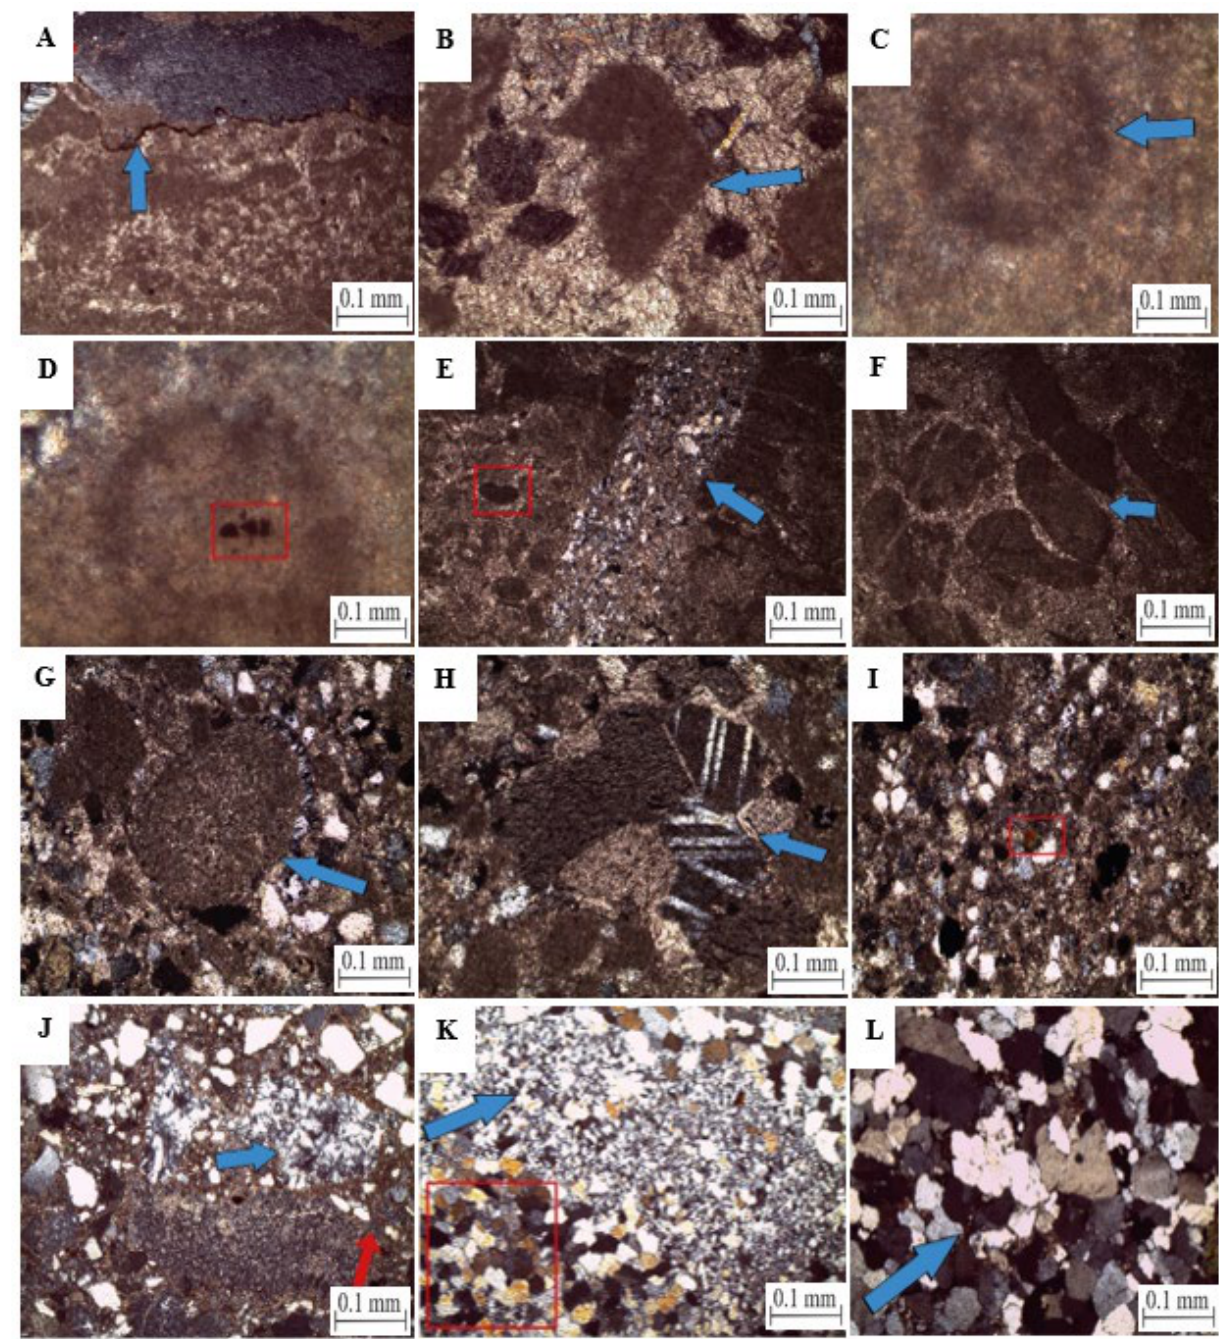
Figure 9. Photomicrographs of the Dol. III, IV and arenite microfacies of the Abbottabad Formation. ( A ) Chert (red arrow) and stylolite vein (blue arrow) along algal mats in Dol. III facies (KA-67; XPL. 4 × ). ( B ) Bioclast (blue arrow) in Dol. III facies (KA-67; XPL. 10 × ). ( C ) Dolomitized ooid (blue arrow) in Dol. III facies (KA-70; XPL. 40 × ). ( D ) Pyrite grains in bioclast in Dol. III facies (KA-70; XPL. 40 × ). ( E ) Cherty and dolomitic vein and rectangle showing pellets in Dol IV facies (KA-50; XPL. 4 × ). ( F ) Intraclasts (blue arrow) in Dol IV facies (KA-50; XPL. 4 × ). ( G ) Dolomite clast (blue arrow) in Dol IV facies (KA-65; XPL. 10 × ). ( H ). Spary calcite (blue arrow) in Dol IV facies (KA-65; XPL. 10 × ). ( I ). Tourmaline crystal (red rectangle) in Dol IV facies (KA-65; XPL. 10 × ). ( J ). Chalcedony (red arrow) and chert (blue arrow) in Dol IV facies (KA-76; XPL. 4 × ). ( K ). Chert (blue arrow) and quartz (red rectangle) in arenite facies (KA-82; XPL. 4 × ). ( L ). Sub-angular, sutured grains of quartz in arenite facies (KA-87; XPL. 4 ×